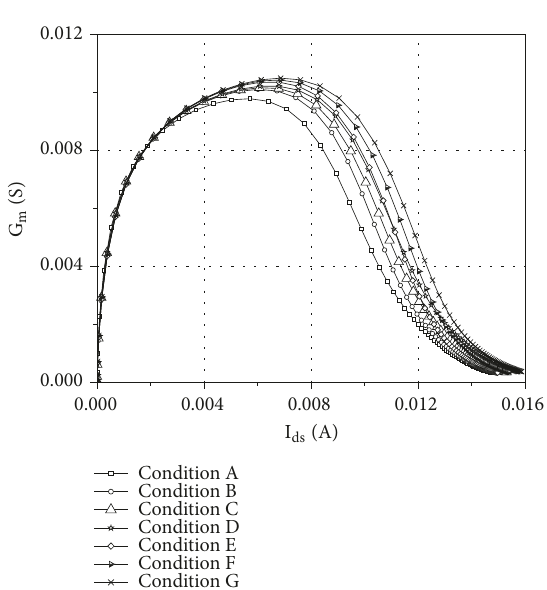
of devices with different length and doping of drift m